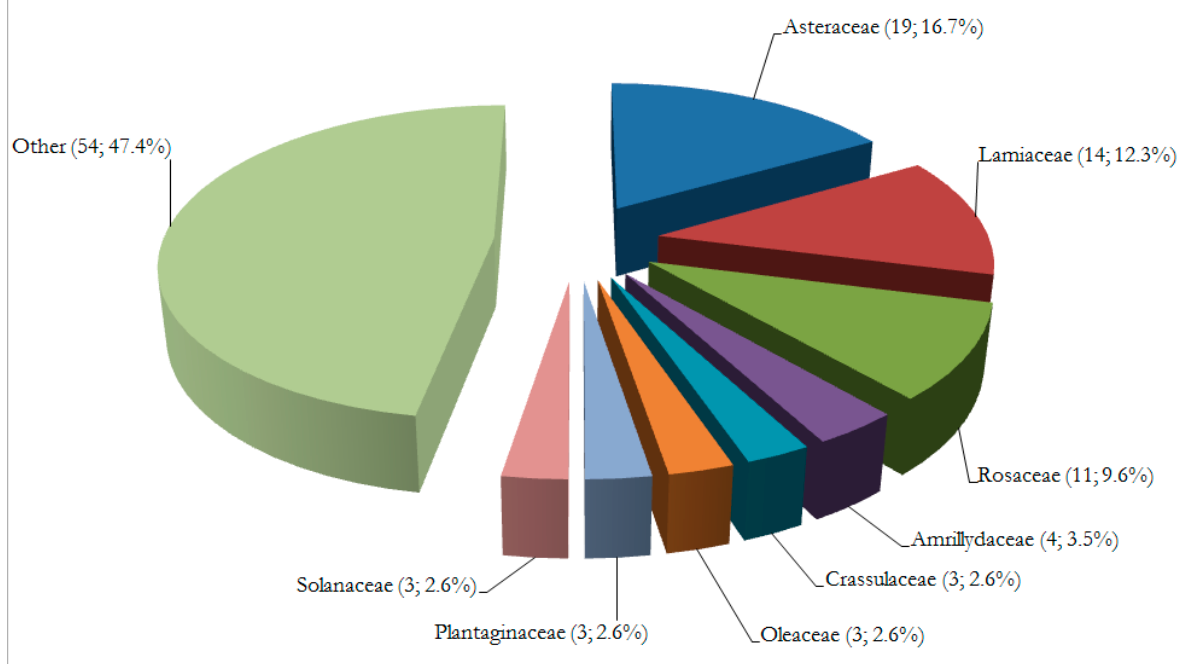
Figure 4. The most frequently mentioned families, depending on the number of species, Others in- clude all families represented with less than 3